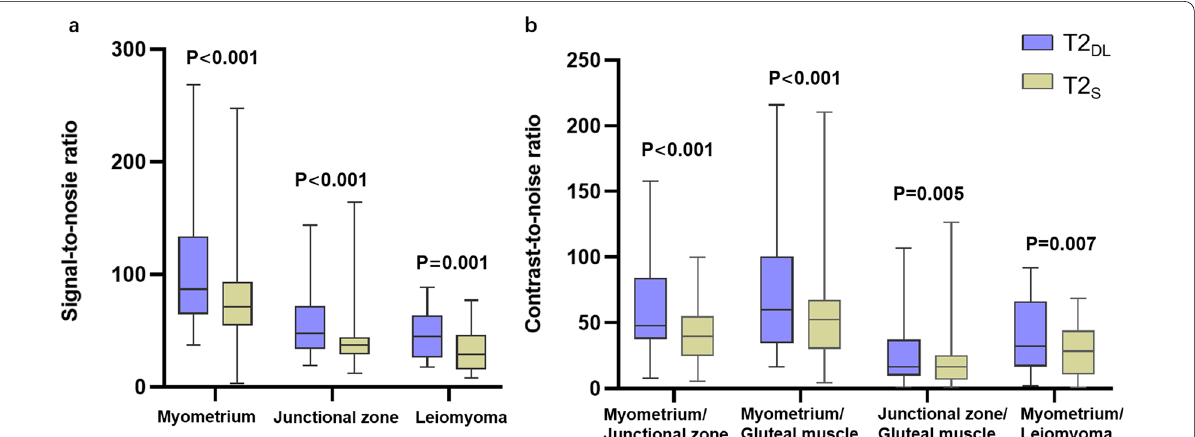
Fig. 2 Box and whisker plots showing the results for SNRs and CNRs using T2w images acquired with T2 DL and T2 S during MRI of the female pelvis. a SNRs of the myometrium, junctional zone, and leiomyoma were significantly higher for T2 DL than for T2 S ( p < 0.001 , p < 0.001 , and p 0.001 , = respectively). b CNRs between the myometrium and junctional zone, between the myometrium and gluteal muscle, between the junctional zone and gluteal muscle, and between the myometrium and leiomyoma were significantly higher for T2 DL than for T2 S ( p < 0.001 , p < 0.001 , p 0.005 , = and p 0.007 , respectively). Center line median; top of box 75th percentile; bottom of box 25th percentile; whiskers smallest and largest = = = = = nonoutlier values. SNR signal‑to‑noise ratio; CNR contrast‑to‑noise ratio; T2 DL deep learning - accelerated T2‑weighted turbo spin echo sequence; T2 S